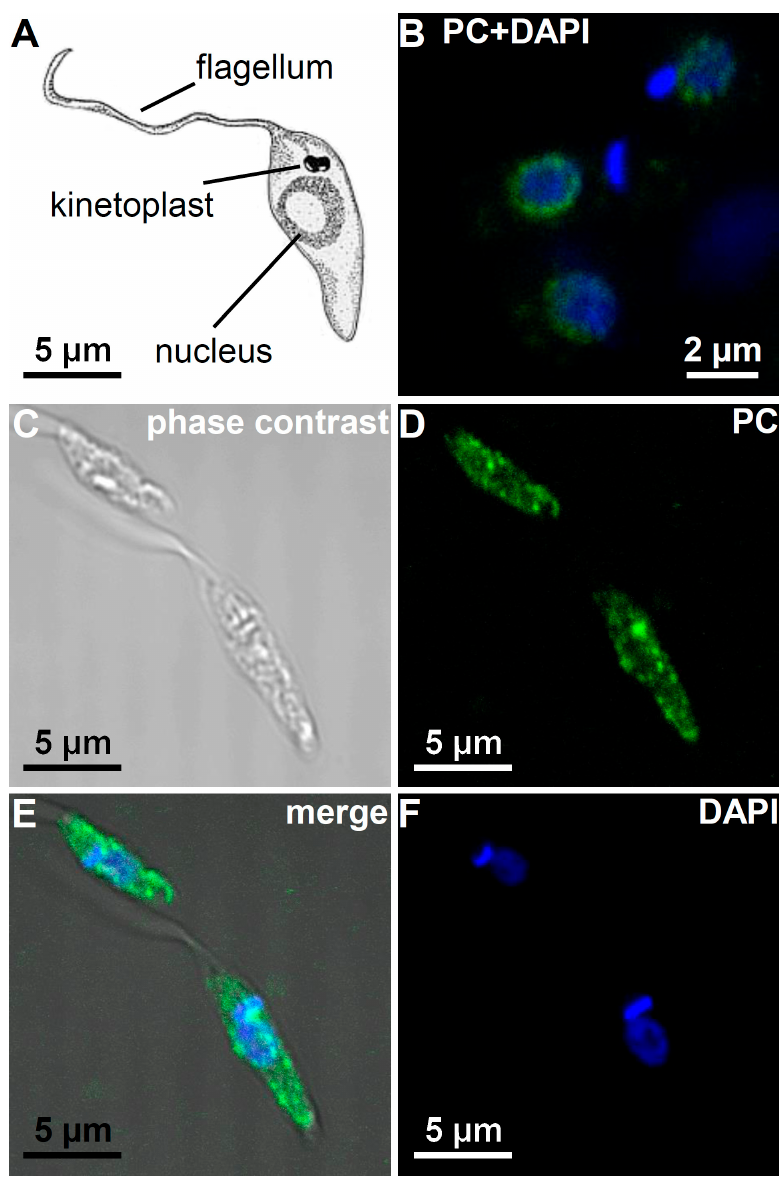
Figure 6. Localization of the PC epitope by confocal microscopy in L. infantum promastigotes. ( A ) Drawing of a L. infantum promastigote (modified from valleyveterinarygroup.com); ( B ) Confocal image of three L. infantum promastigotes after three days in culture. The nucleus and the kinetoplast are stained with DAPI (shown in blue). The PC epitope is recognized by the TEPC-15 antibody as a pearly ring around the nucleus (shown in green); ( C – F ) Confocal images of two L. infantum promastigotes after ten days in culture. The PC epitope is now localized throughout the whole cytoplasm ( D ); still having a rather dotted and non-homogeneous appearance; Image ( E ) shows a merge of the phase contrast image ( C ) with the PC- ( D ) and DAPI stain ( F ).